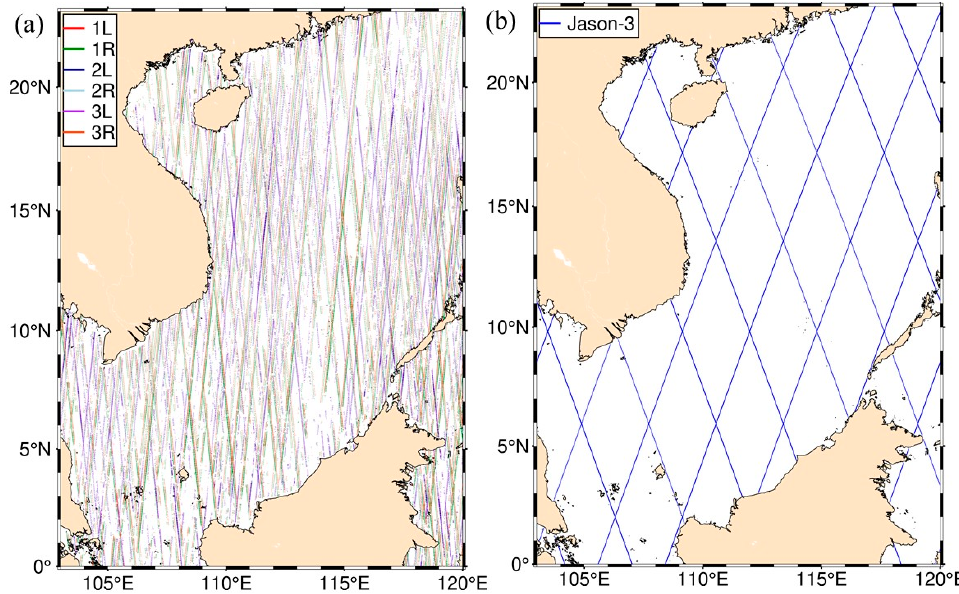
Figure 3. ( a ) Ground track of ICESat-2 strong-beam SSHs in the SCS; ( b ) ground track of Jason-3 SSHs in the SCS.